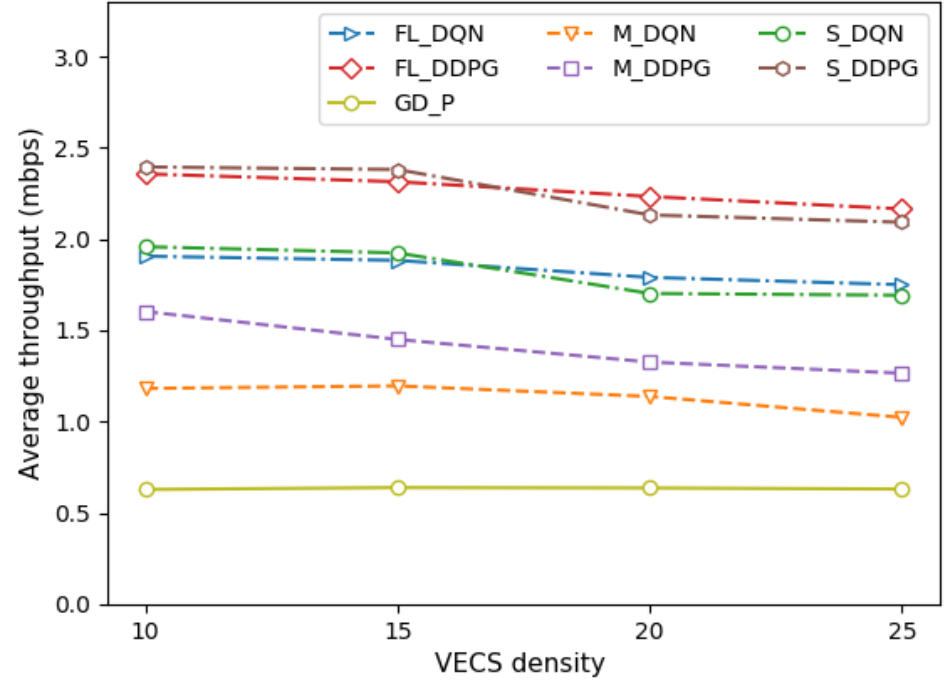
Figure 5. Comparison of average throughput under different VECS densities.